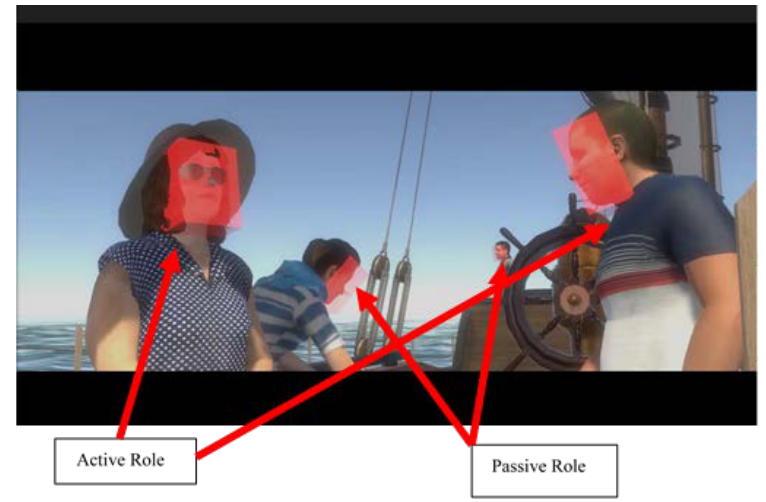
Figure 2. Basic roles: active and passive.